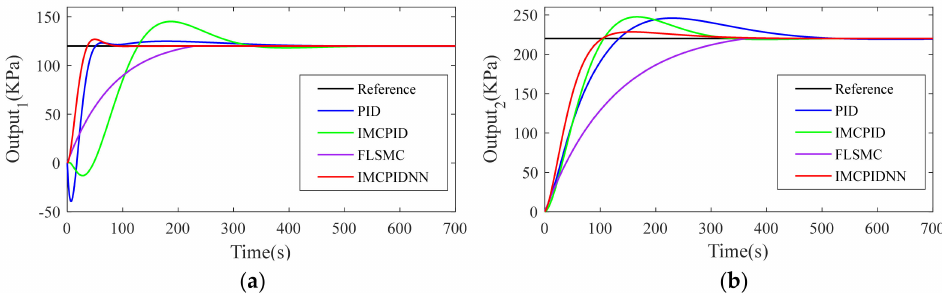
Figure 10. Comparison of concurrent step responses with +40% variation on time constant and gains: